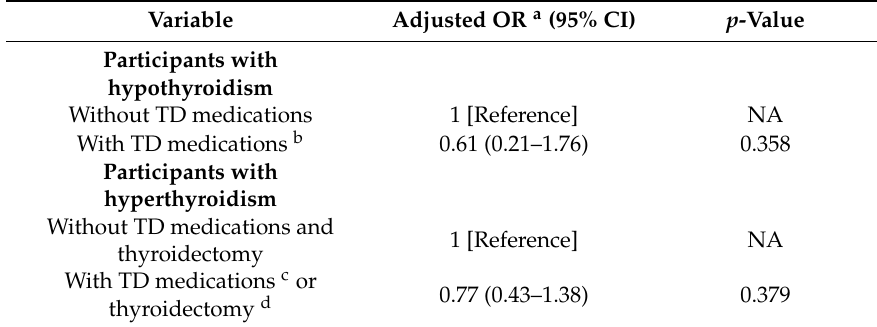
Table 3. Subgroup Analysis for Treatment-Adjusted Odds Ratio of Sensorineural Hearing Loss Associated With Thyroid